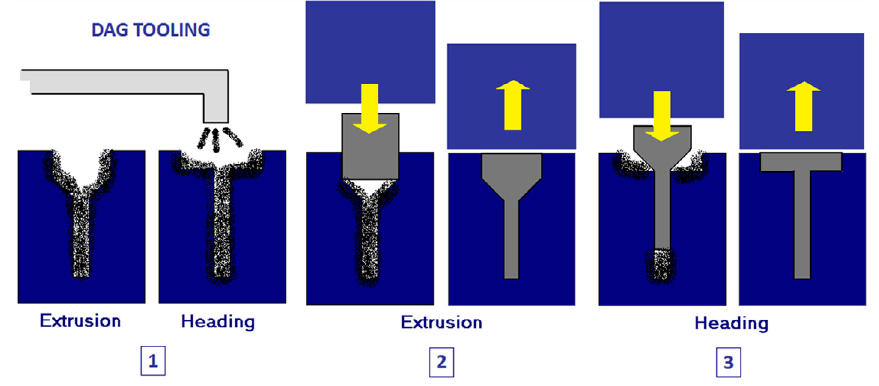
Figure 8. Dag application in extrusion and heading (McIntosh).